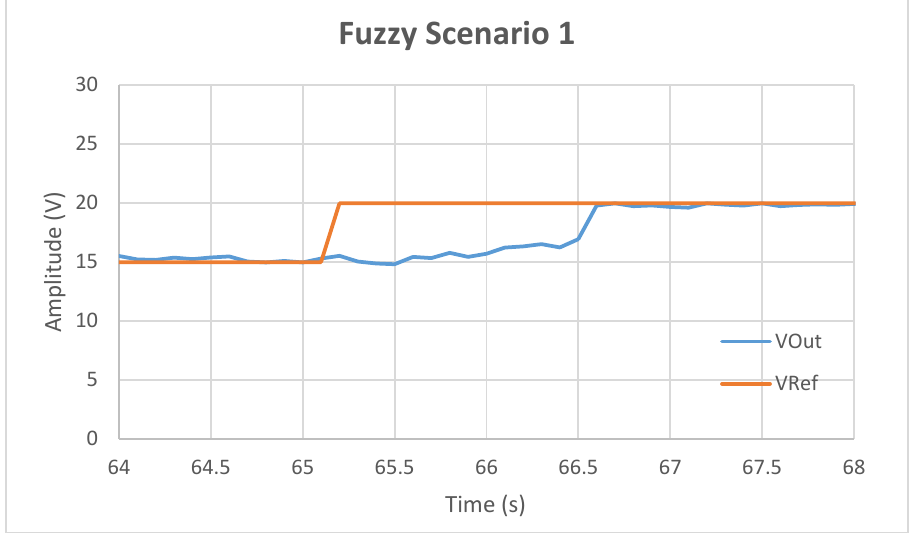
Figure 16. The results of set point changes with fuzzy logic controller on 64 to 68 s.